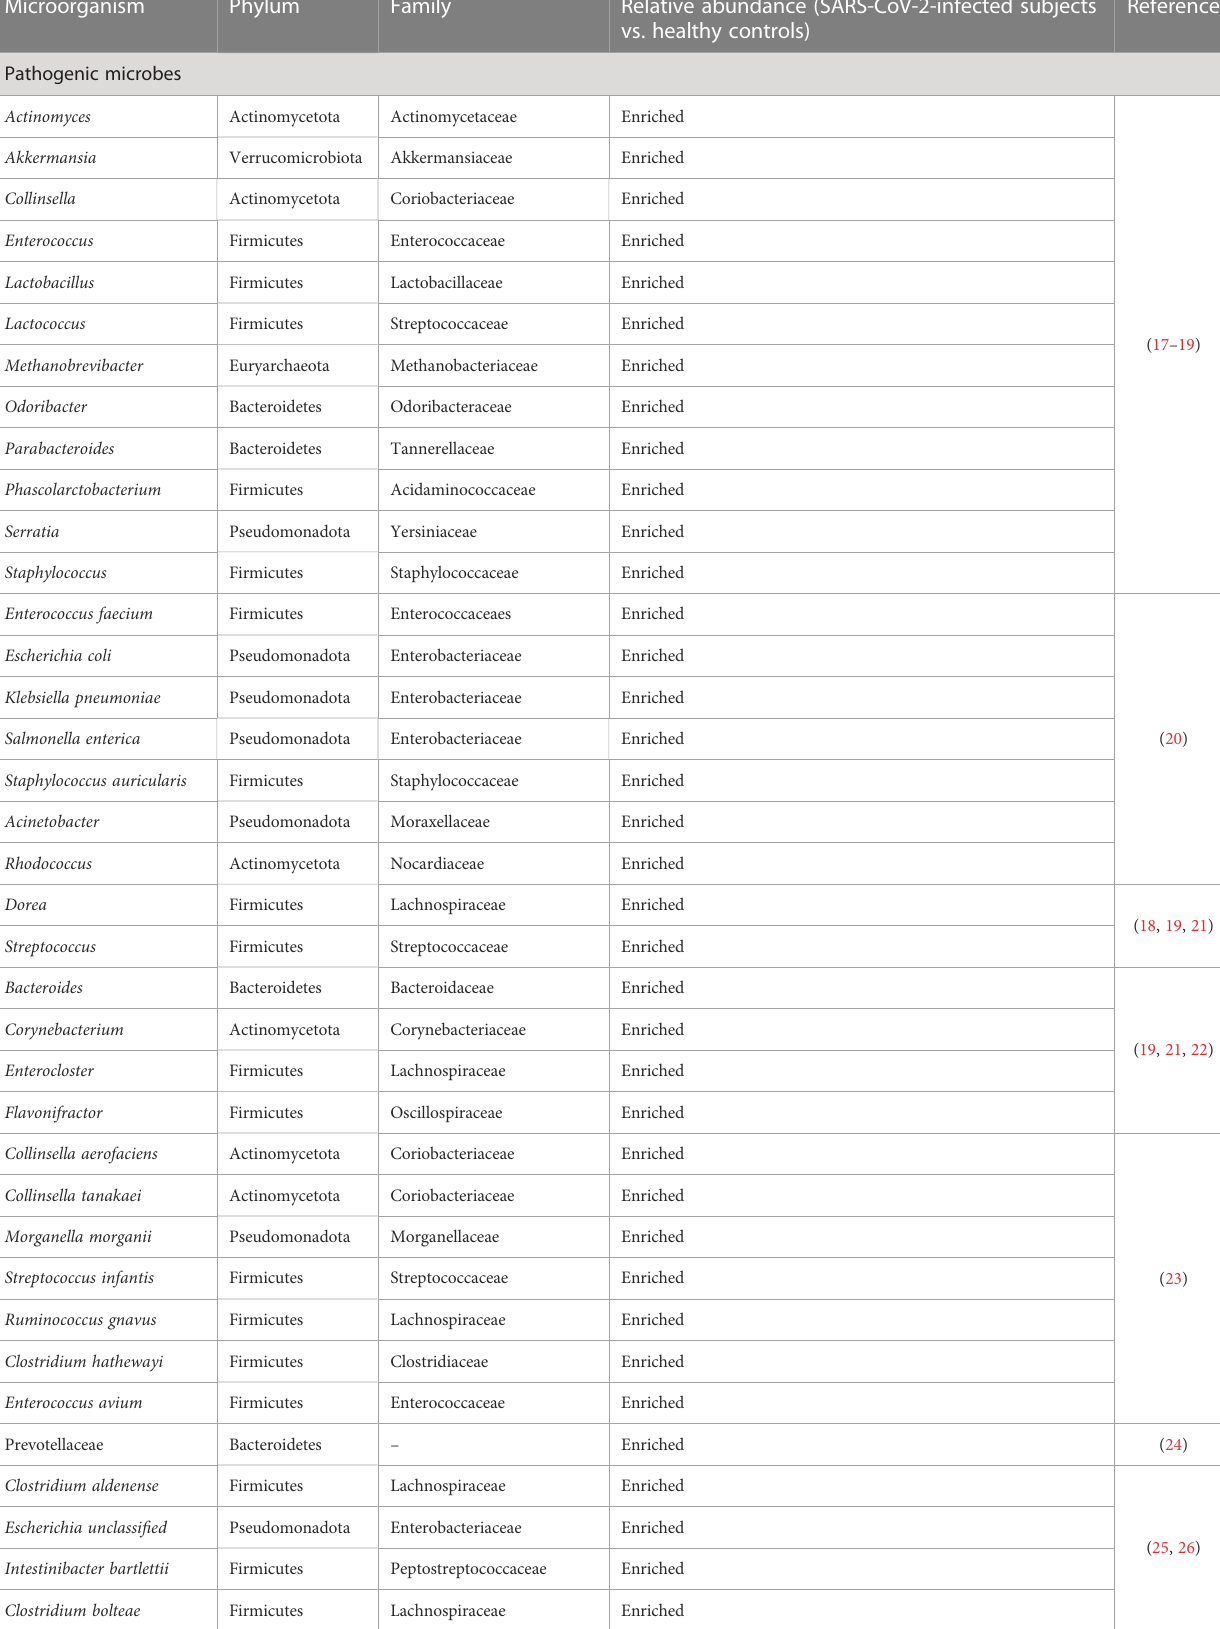
TABLE 1 Gut microbiota pro fi les of SARS-CoV-2-infected